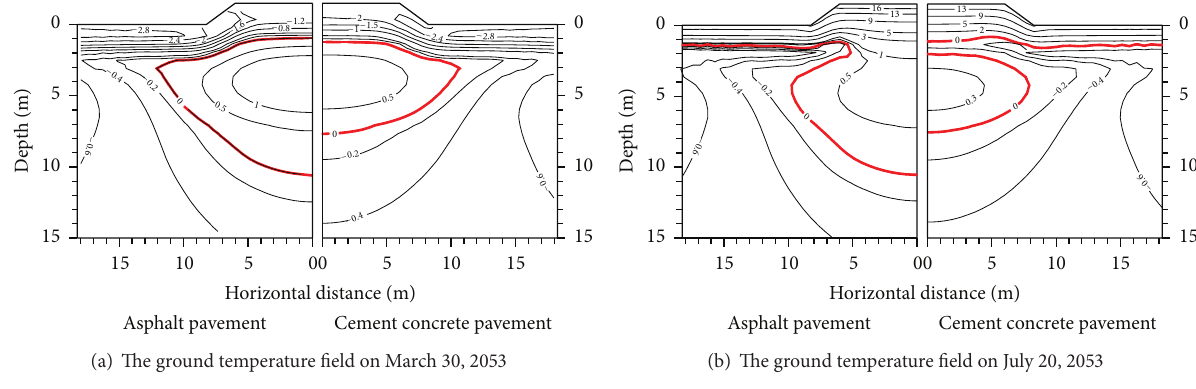
Figure 9: Temperature values of the 50th year under concrete pavement and asphalt pavement (width of